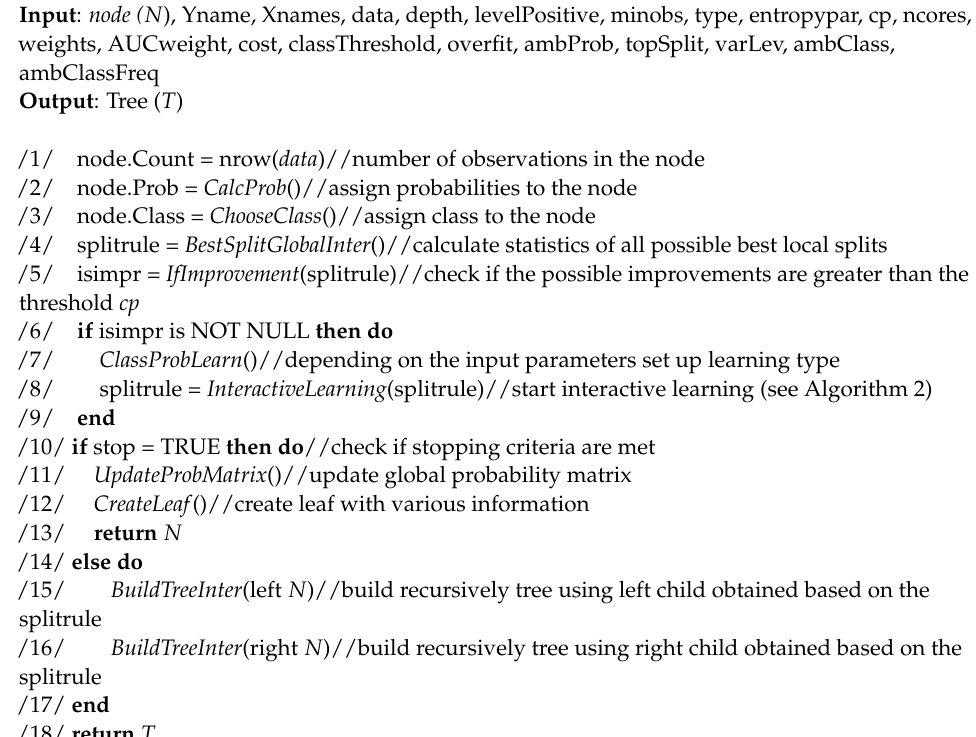
Algorithm 1: BuildTreeInter